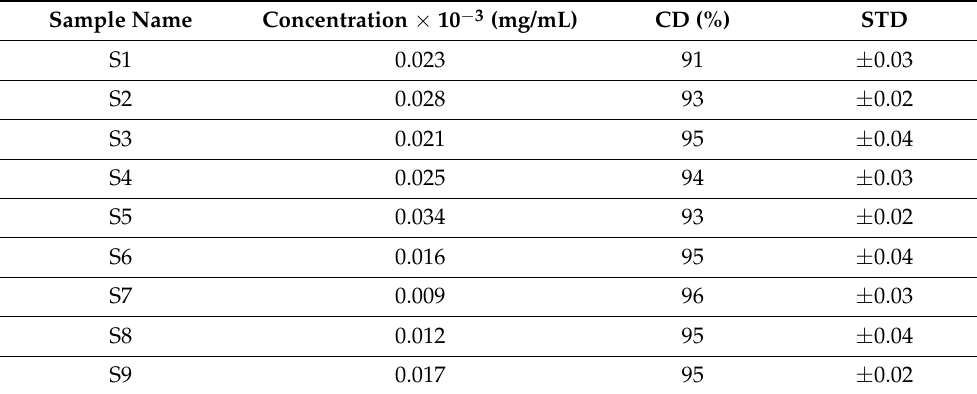
Table 2. The concentration of salecan in the washing solution determined by UV-Vis measurements and the calculated crosslinking